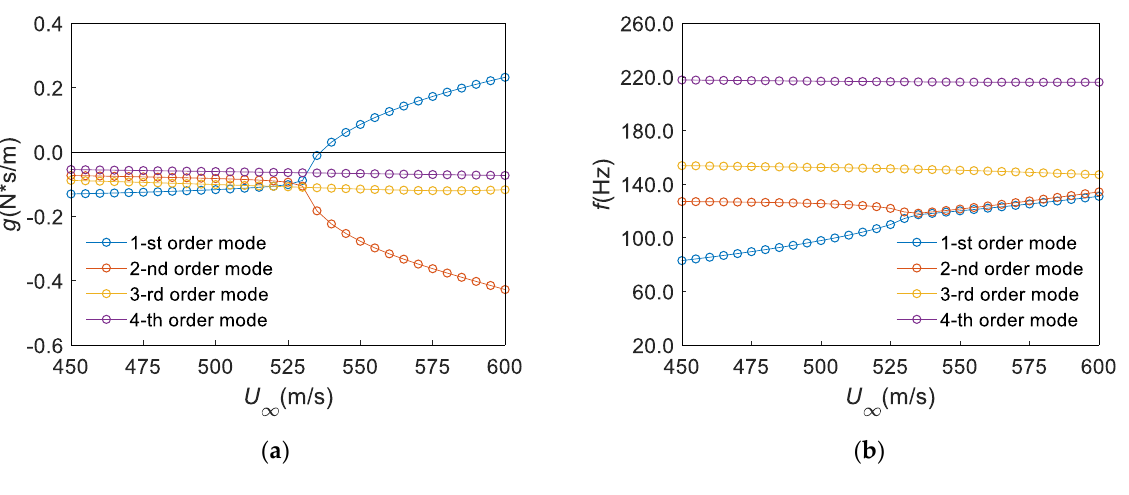
Figure 7. Results of flutter calculation (QP): ( a ) U − g , ( b ) U − f